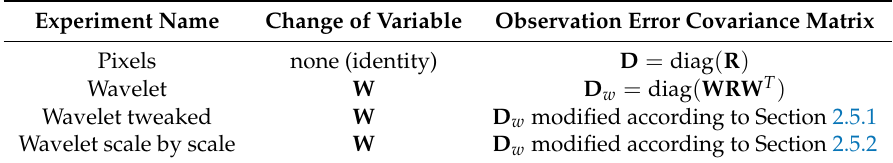
Table 1. Summary of the experiments description: name, change of variable, observation error covariance